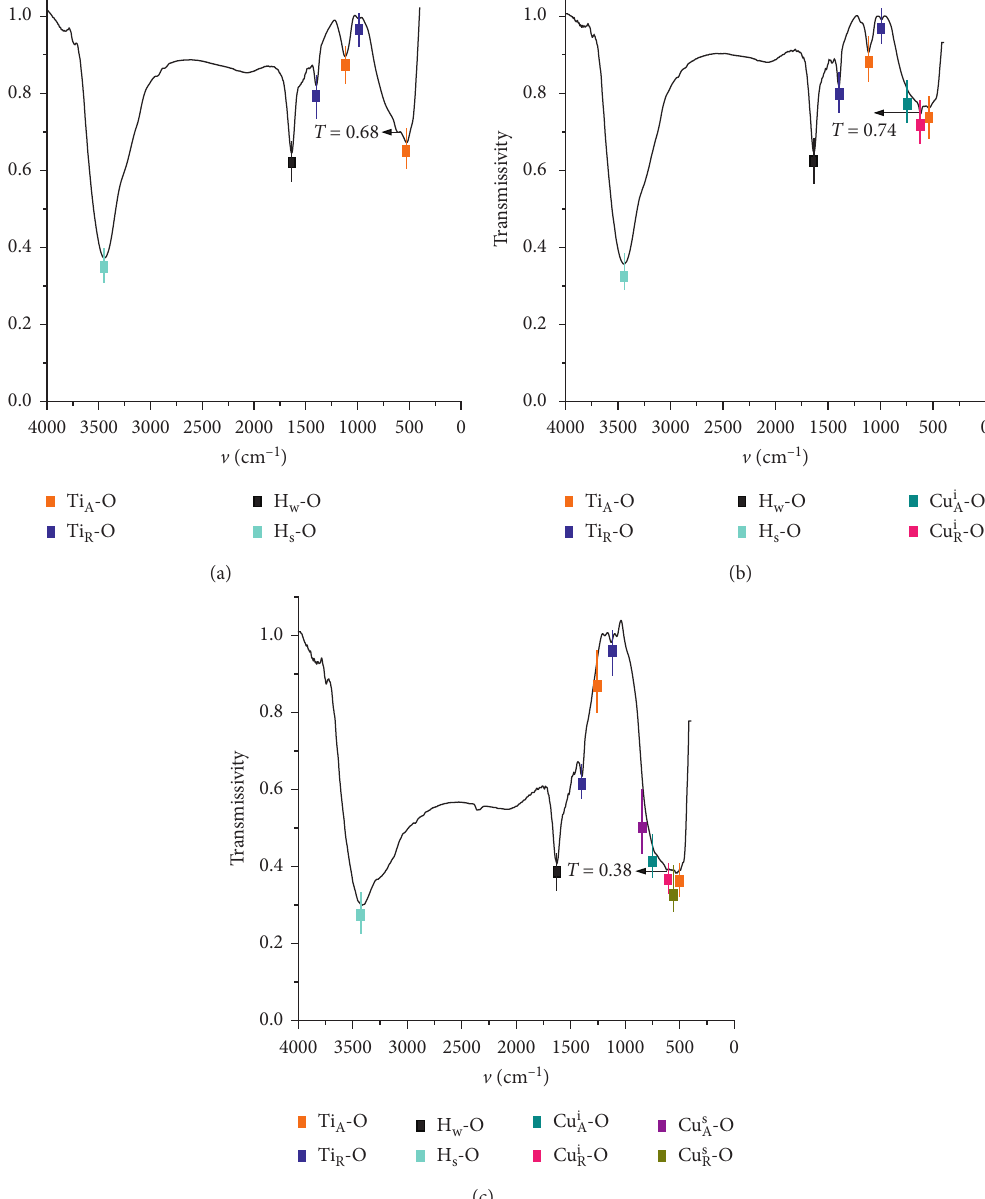
2 samples with different doping concentrations at